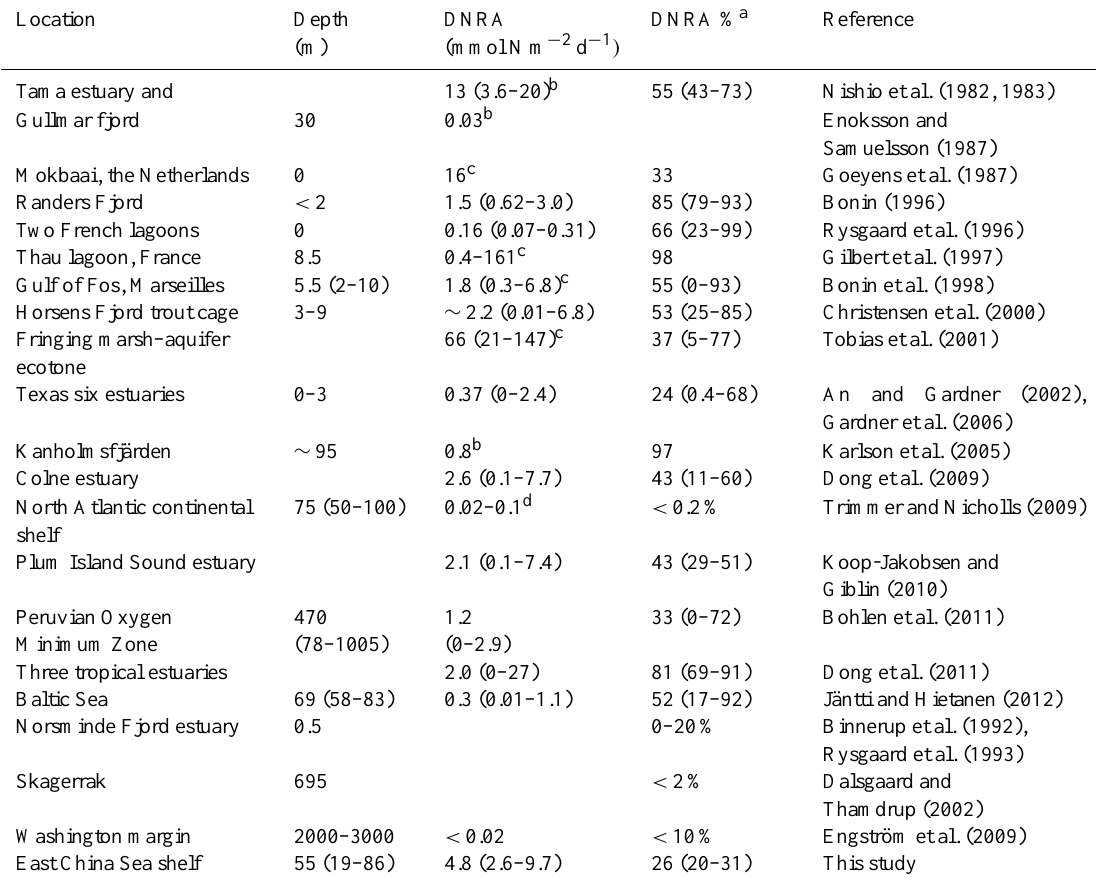
Table 4. DNRA rates reported from other marine sediment. The data in parentheses represent the range.